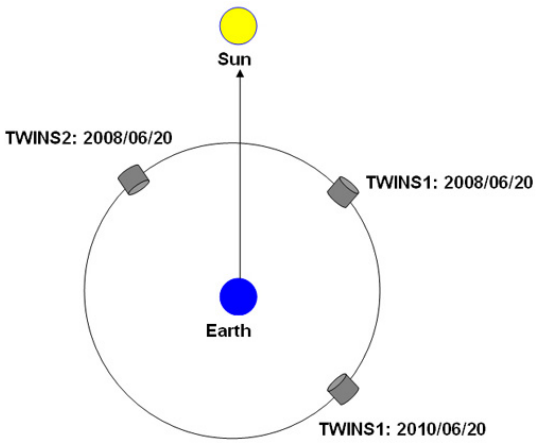
Fig. 1. Spacecraft positions: The TWINS1/2-apogee positions (grey cylinders) included in the summer-solstice dataset, which is com- bined from TWINS1/2 2008 and TWINS1 2010 summer-solstice measurements.